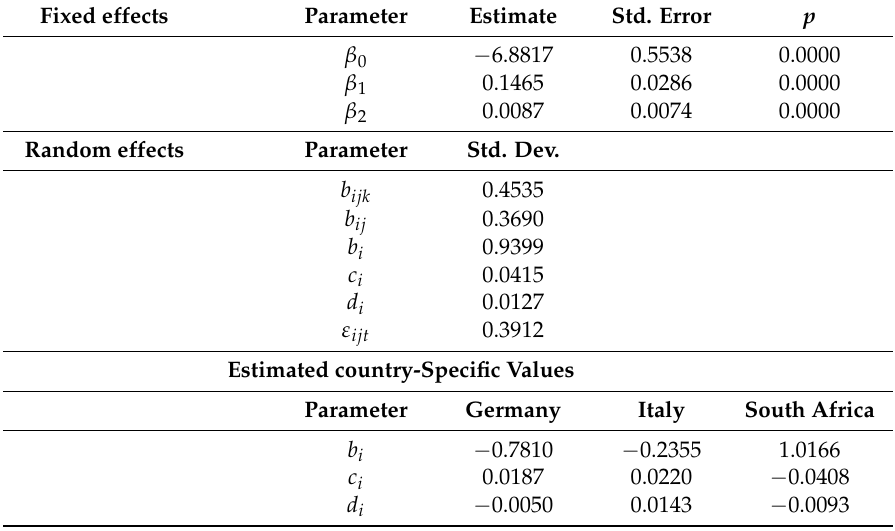
Table A1. Model parameters for the linear mixed effect model Equation (3) displaying the performance of growth level (Figure 4). Parameter estimates for each experiment’s fixed effects with standard errors (Std. Error) and significances ( p ) and the standard deviation (Std. Dev.) of random effects. Estimated country-specific values were added to the random effects, as they are needed for the curve display in Figure 4.